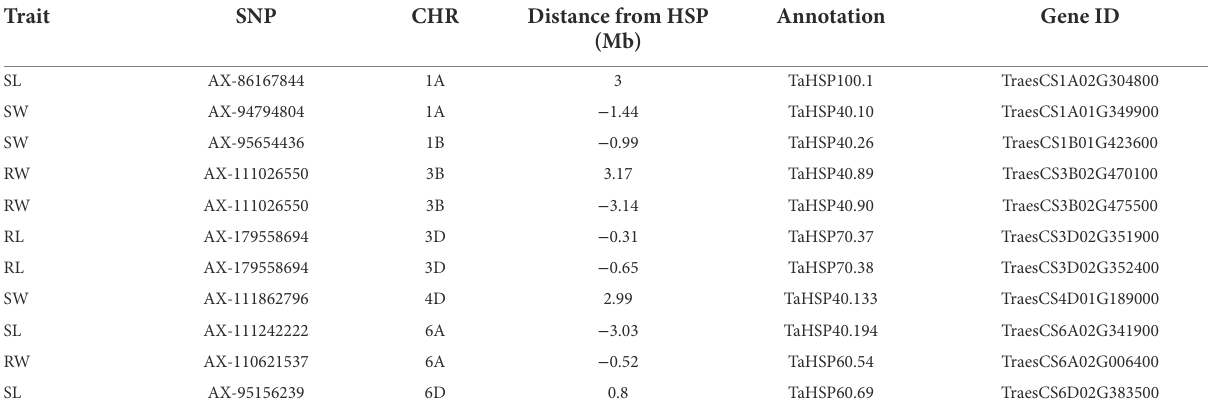
TABLE 3 HSP genes associated with QTNs identified in